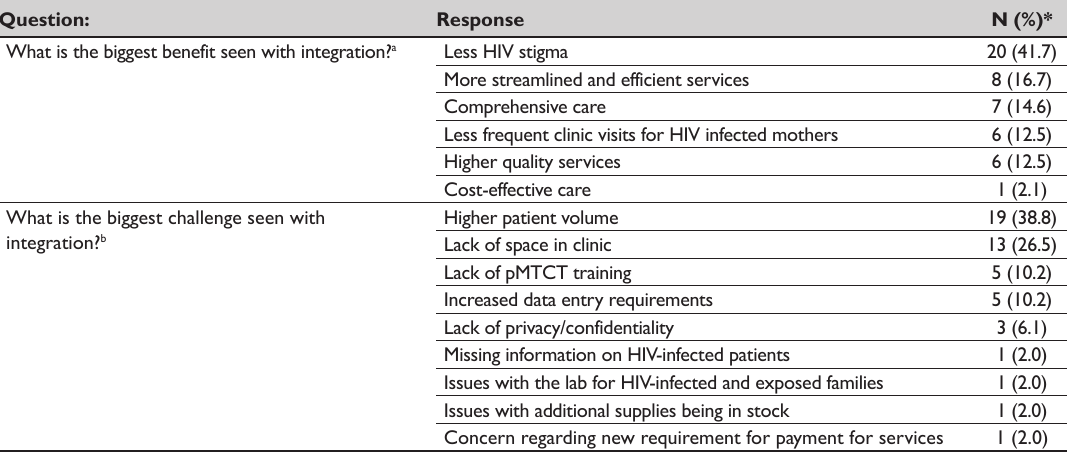
Table 3: Summary of clinical provider survey results Question: